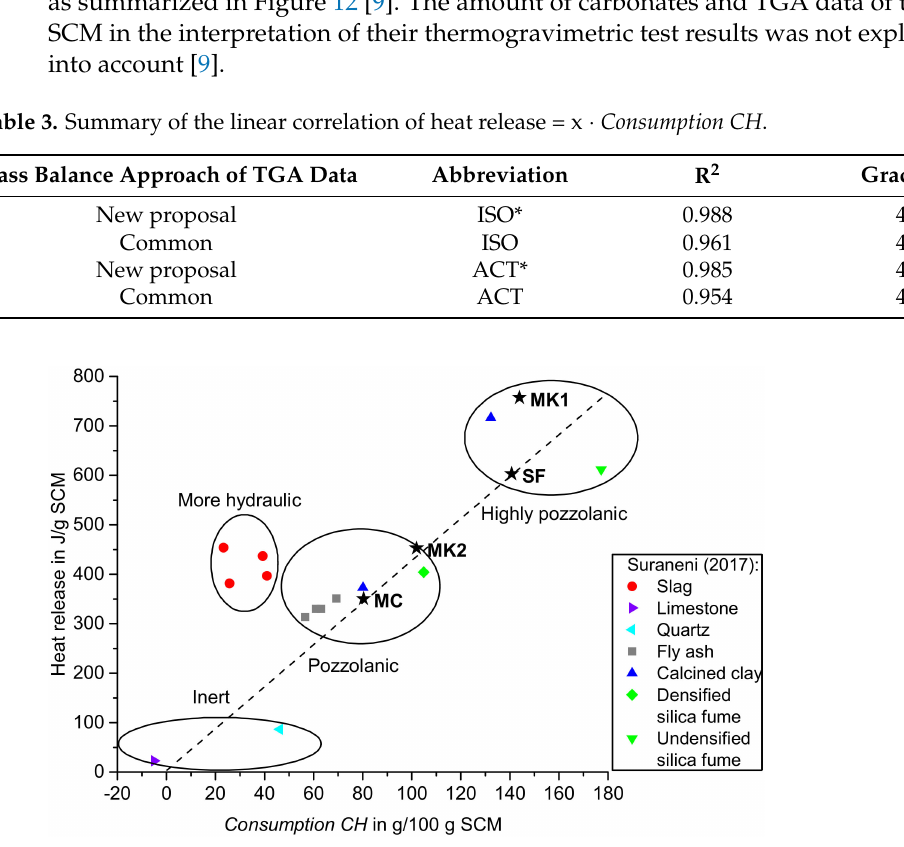
Figure 12. Results of this study SF, MK1, MK2, and MC (ISO*: Dried with isopropanol and calculated according to the proposed mass balance approach) shown in the figure adapted from Suraneni and Weiss